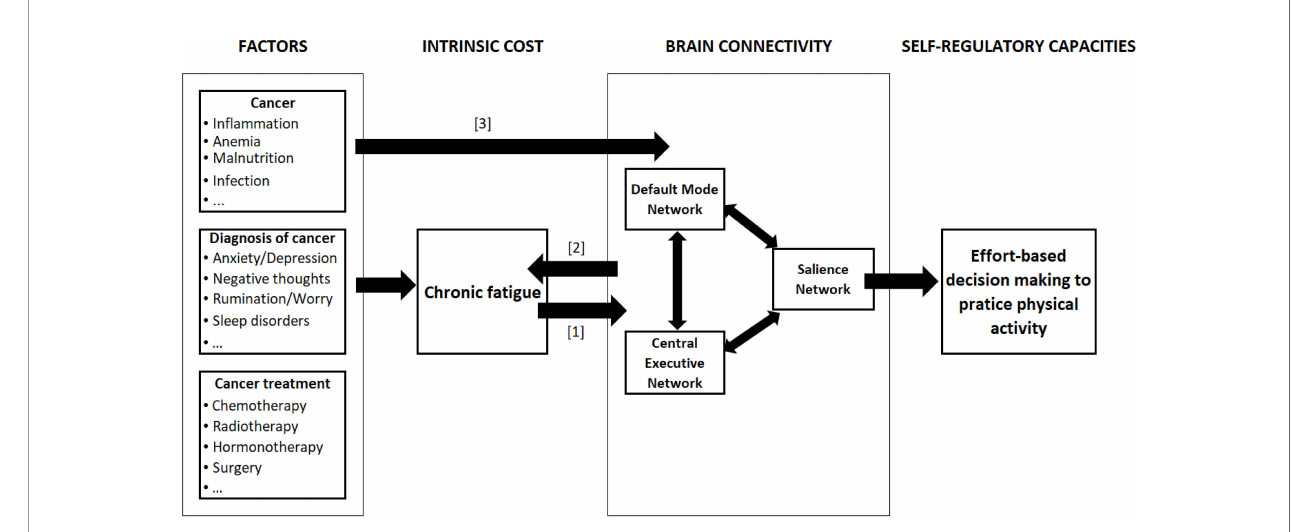
FIGURE 1 | Relationships between chronic fatigue and brain connectivity. The fi gure represents the links between cancer-related factors and effort-based decision- making to practice PA. The causal relationship between chronic fatigue and brain connectivity (BC) can be of three types: [1] fatigue causes changes in BC; [2] the change in BC causes fatigue; [1&2] a bidirectional relationship. Moreover, factors such as cancer itself, diagnosis and treatment of cancer may directly alter the brain connectivity